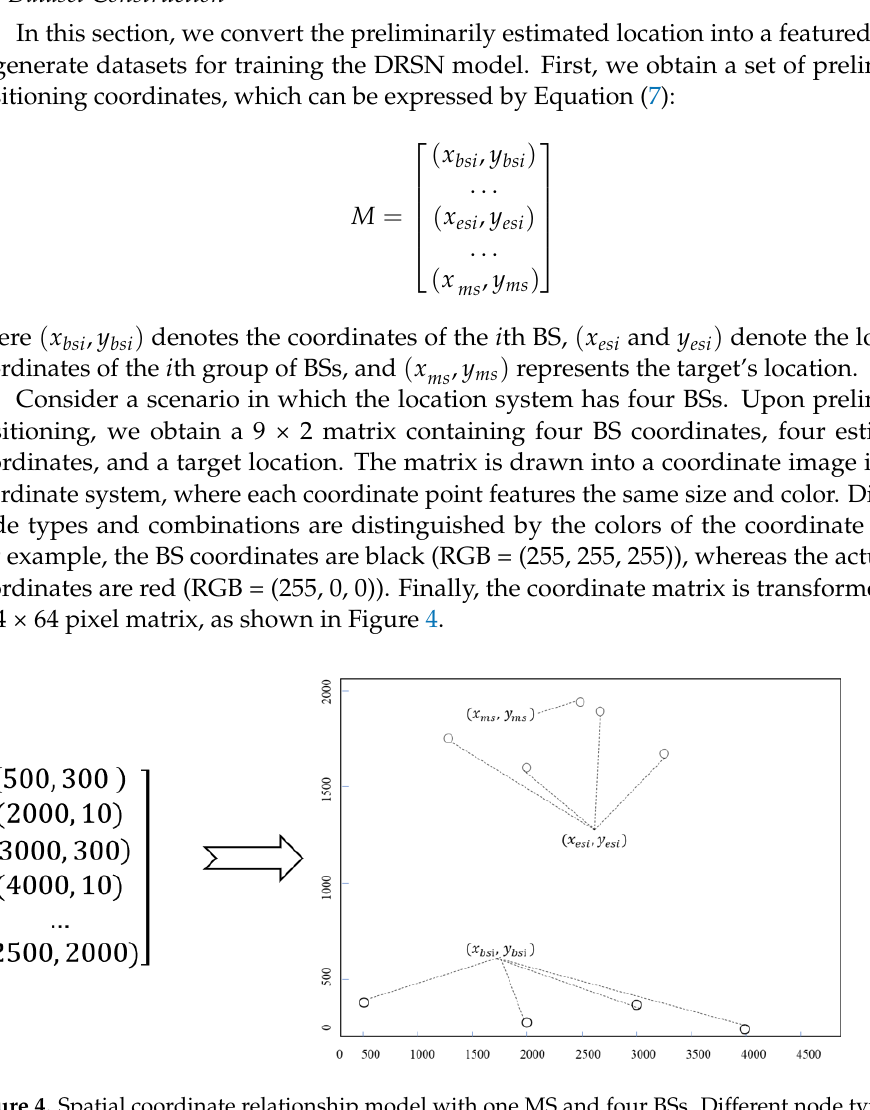
Figure 4. Spatial coordinate relationship model with one MS and four BSs. Different node types and combinations have the same size and different